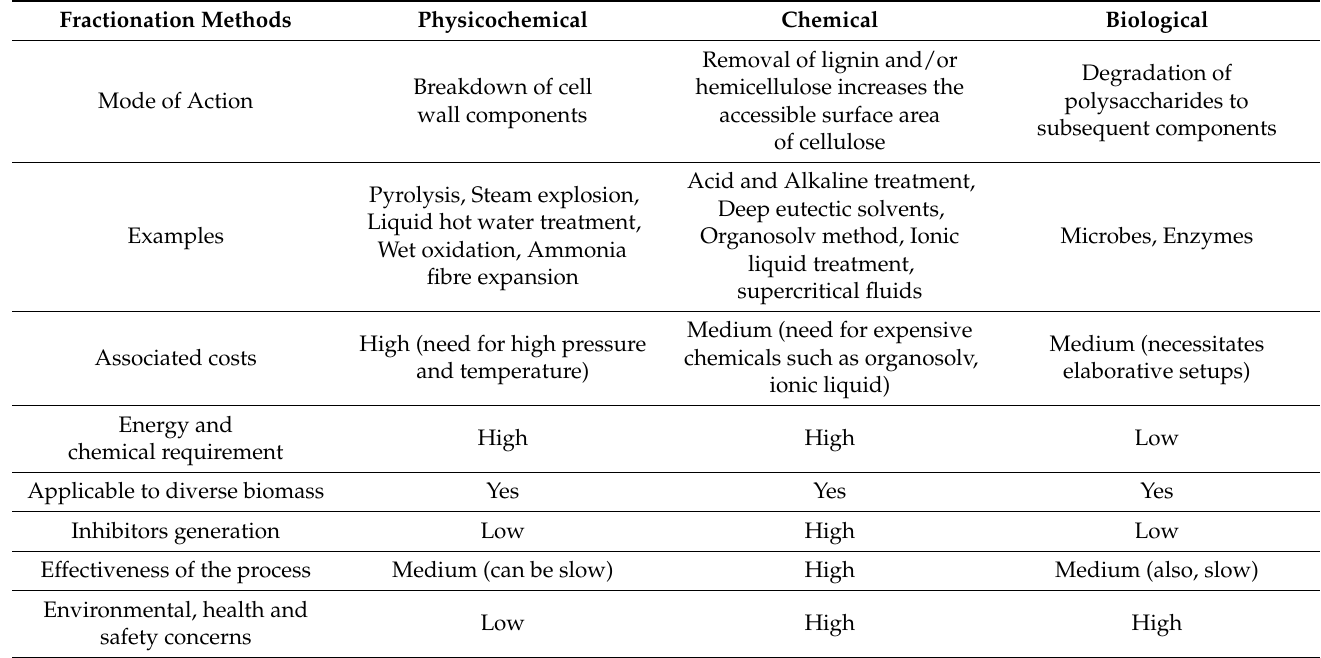
Table 2. Advantages and limitations of Fractionation